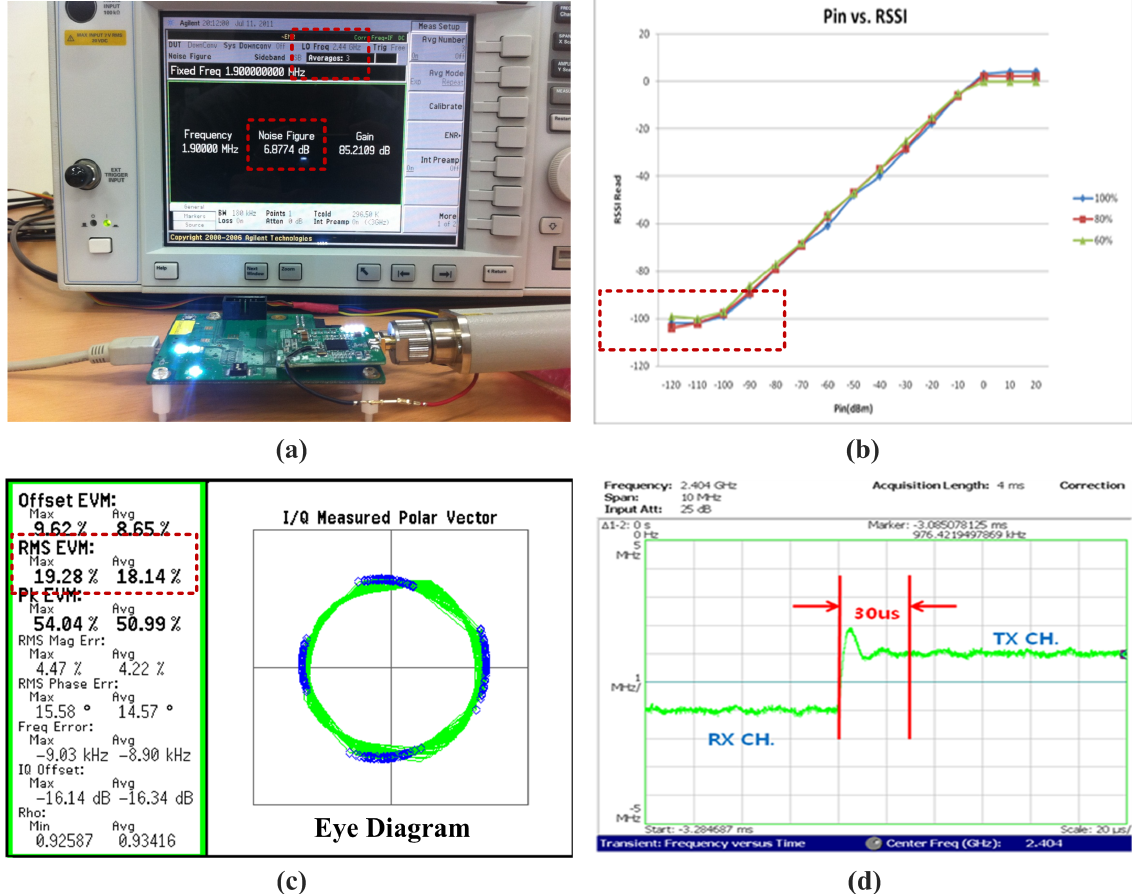
Figure 11. IEEE 802.15.4 RF Transceiver Measurement Results. ( a ) Receiver cascaded noise figure (NF); ( b ) The maximum gain of AGC; ( c ) Vector signal analysis of transmitter; ( d ) PLL turnaround time.